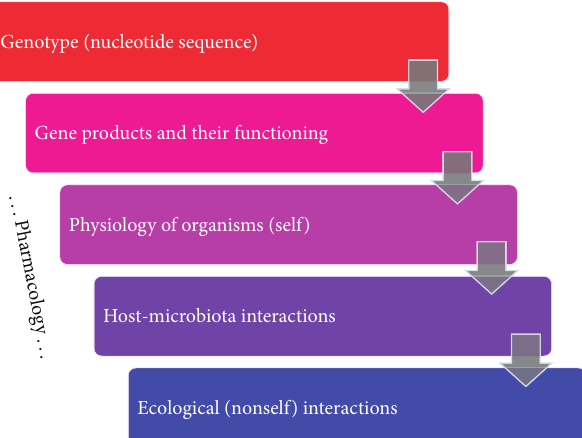
Figure 2: The realm of pharmacology includes an organism’s gene products and their functioning, the overall physiology of an organism, the interactions that occur between a host organism and their associated microbiota, and even aspects of an organism’s ecology. The realm of pharmacology. Pharmaceuticals interact with individual body molecules, including gene products as well as products of enzyme-mediated catalysis. The goal with pharmacology, in turn, is a modification of the physiology and particularly the pathophysiology of treated organisms. Organismsthemselvesgenerallyconsistofmorethanjusttheproductsoftheirowngenomesbutalsotheproductsoftheirassociatedmicrobial symbionts [221]. An important component of pharmacology therefore is the interaction of pharmaceuticals with this microflora. Not shown is the impact of drugs that serve either as mutagens or as nucleic acid damaging agents, which can affect genotype as